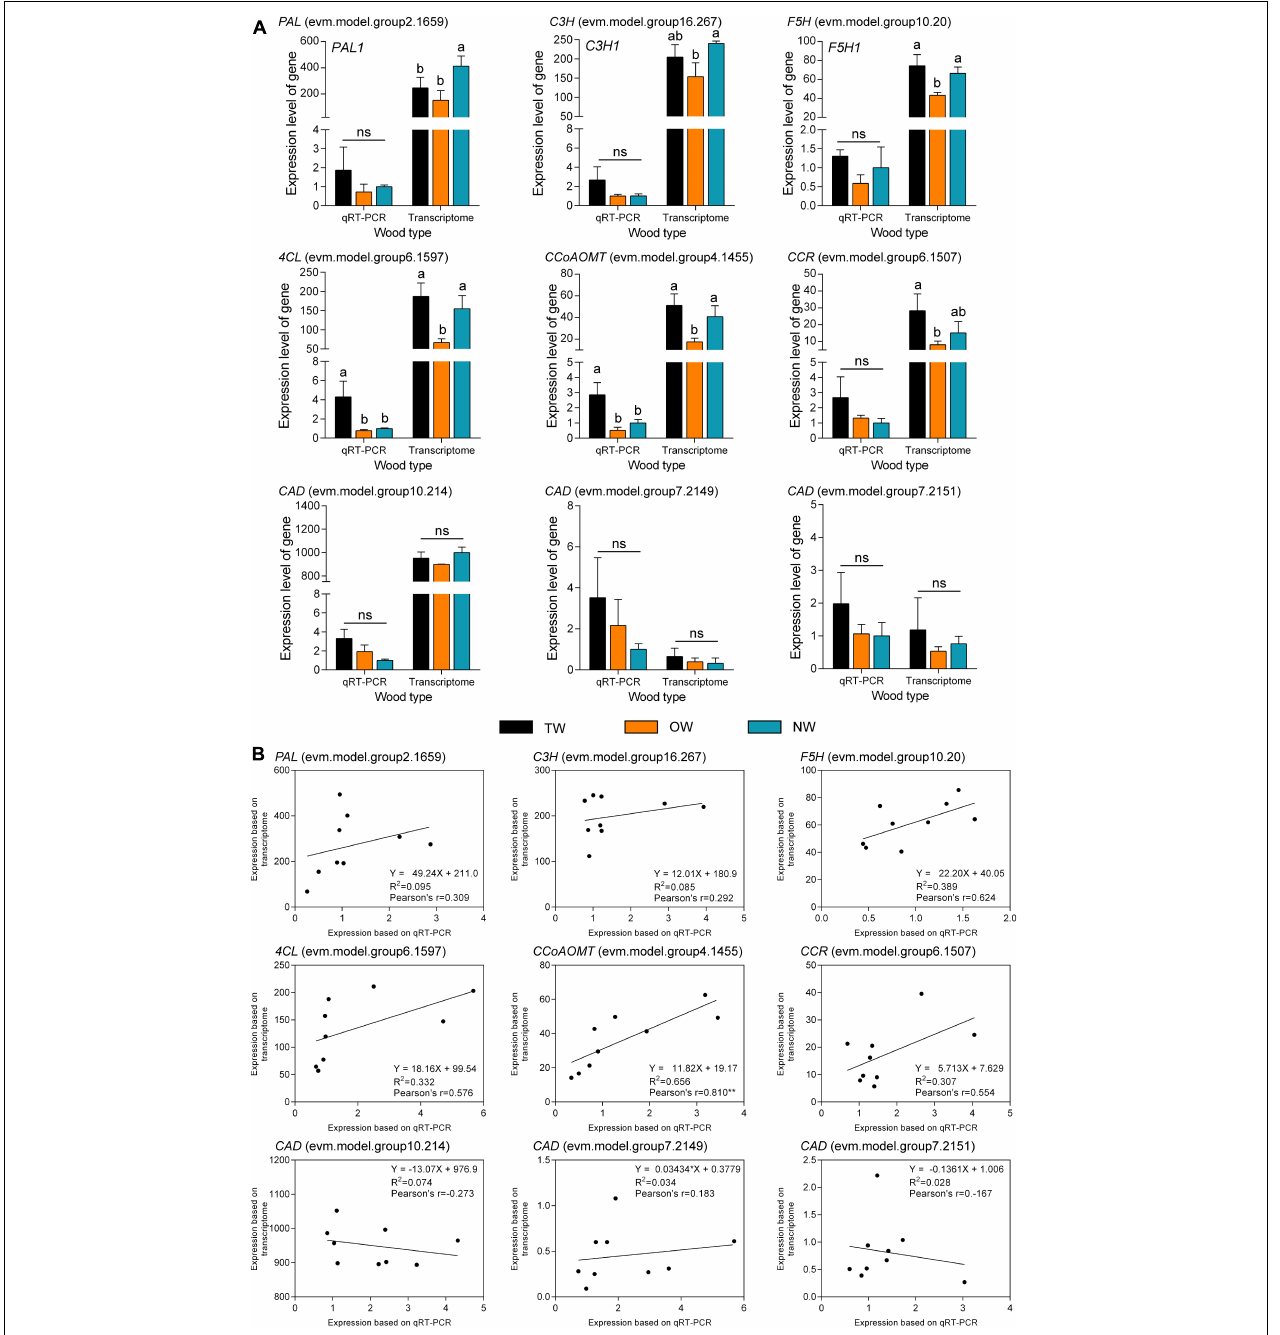
FIGURE 6 | qRT-PCR validation of transcripts involved in lignin monomer biosynthesis in tension wood (TW), opposite wood (OW), and normal wood (NW). (A) qRT-PCR of candidate genes. (B) Correlation analysis of qRT-PCR and transcriptome results for candidate genes. Duncan’s method was used for multiple comparisons. Different lowercase letters indicate a 5% significant difference. ns, not significant. Pearson’s r indicates the Pearson correlation coefficient. ** indicates 1% significance. The expression of NW was as the control in qRT-PCR